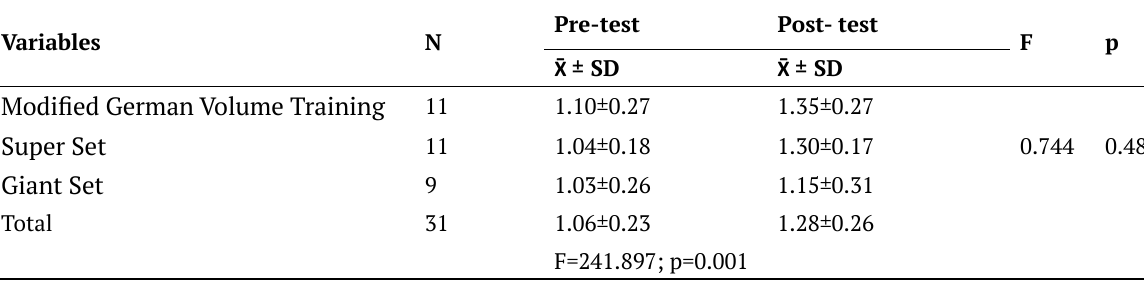
Table 9. Pre-test and post-test comparison of barbell row values of the